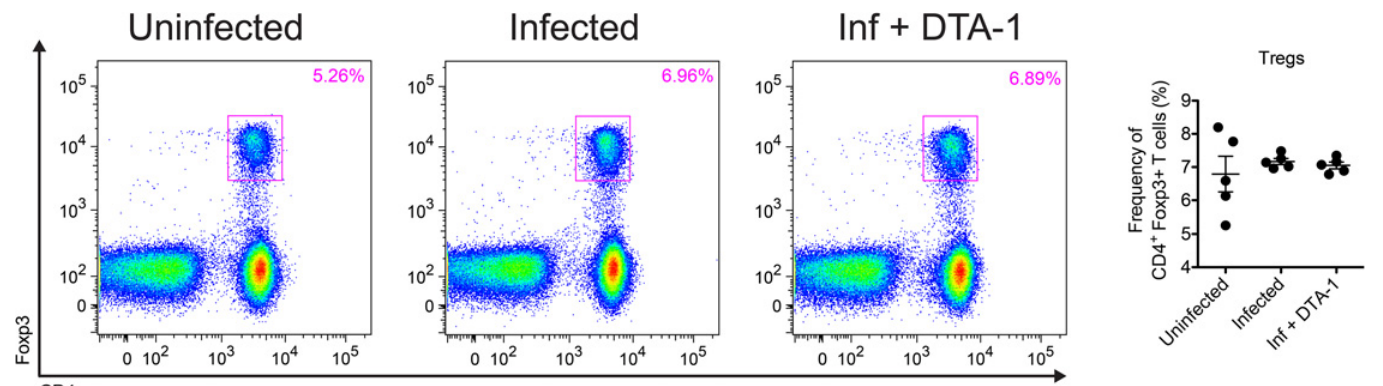
Fig 7. GITR activation has no effect in the Treg cell compartment during T . gondii infection. C57BL/6 Foxp3 GFP/+ mice were treated or not with one dose of DTA-1 (500 μ g/mouse) one day before the infection with 20 cysts of T . gondii i.p. Mice were euthanized at 5 dpi and had their spleens collected and analyzed for Foxp3 expression by flow cytometry. Results were shown as the percentage of CD4 + Foxp3 + cells gated on CD3 + cells (300,000 events). Each FACS plot corresponds to a representative individual mouse. Error bars indicate mean +/- SEM. The experiment was performed twice, with n = 5